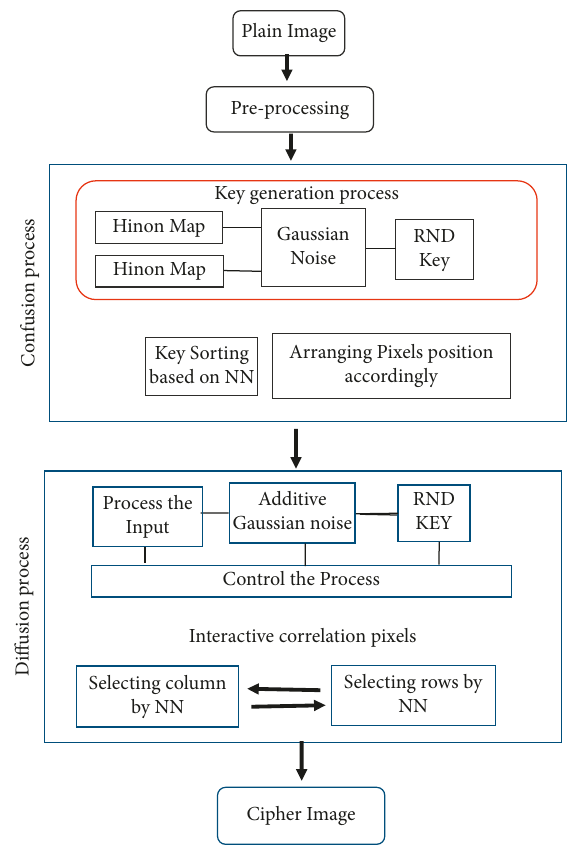
Figure 5: A general overview of the proposed system.